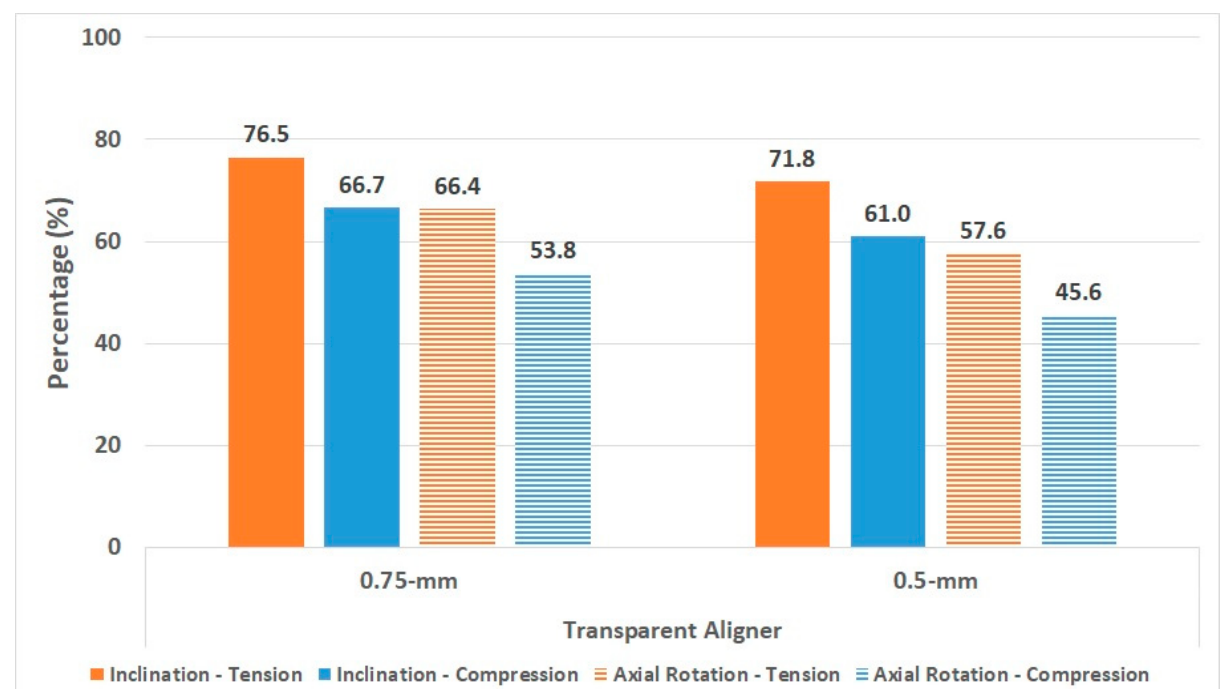
Figure 16. Principle stress of alveolar bone induced by the transparent aligner as compared to that induced by the fixed appliance.